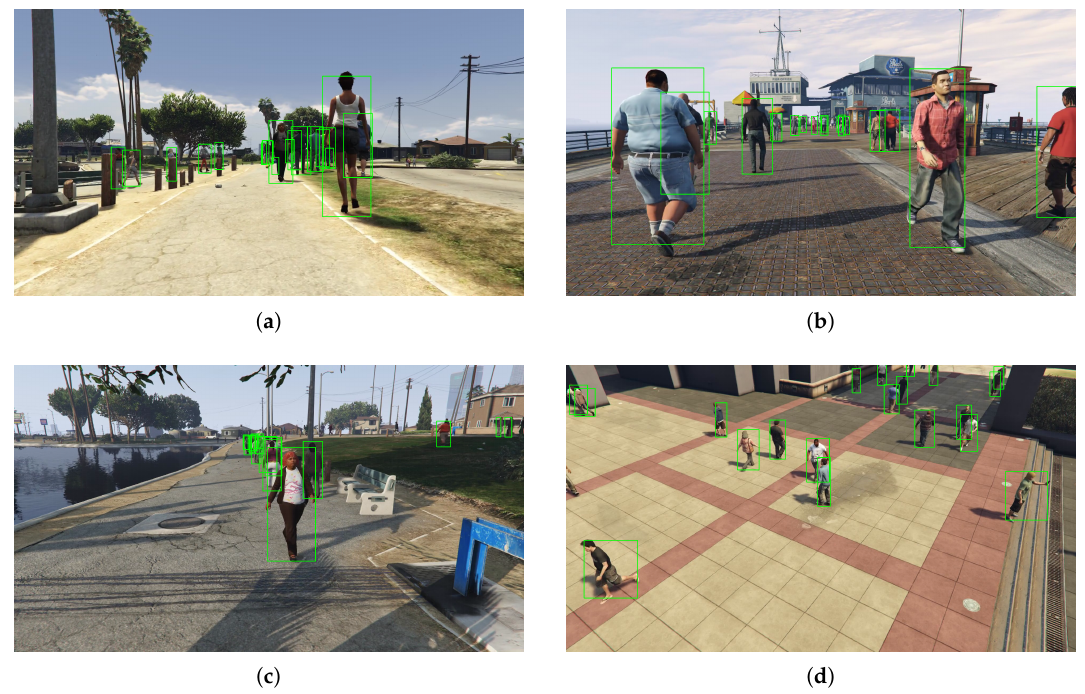
Figure 3. Examples of images of the ViPeD dataset together with the sanitized bounding